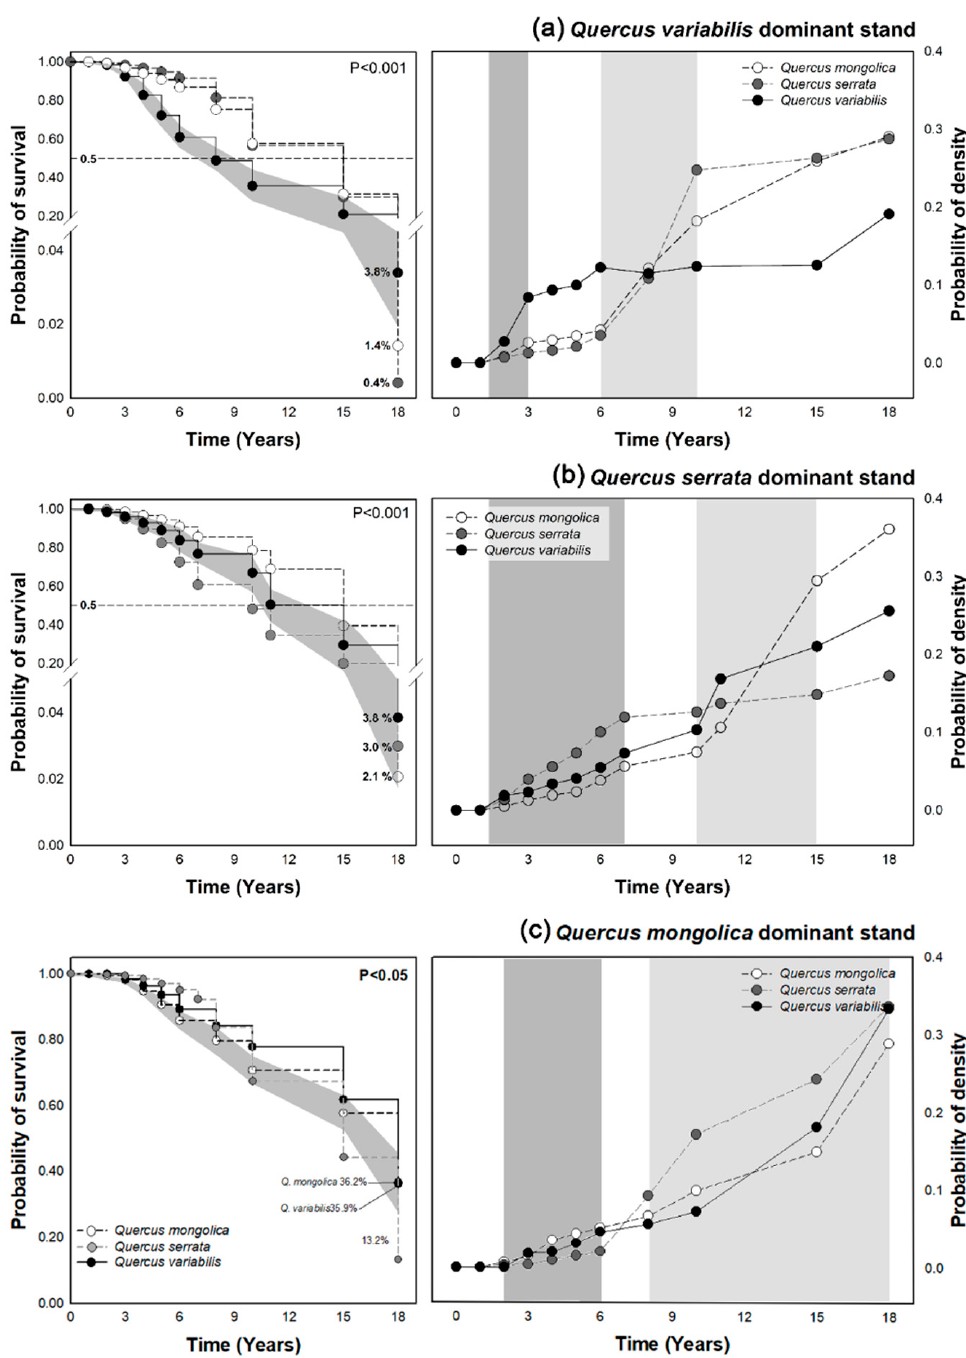
Figure 4. Sprout survival and density probability of each Quercus spp. (oak) in the naturally regenerated forest. ( a ), Quercus variabilis -dominant stand; ( b ), Quercus serrata -dominant stand; ( c ), Quercus mongolica -dominant stand. In the left two figures, the gray color means a 95% confidence interval of the dominant species. In the right two figures, the dark gray color means interval with high density probability of dominant species and light gray means interval with high density probability non-dominant species.